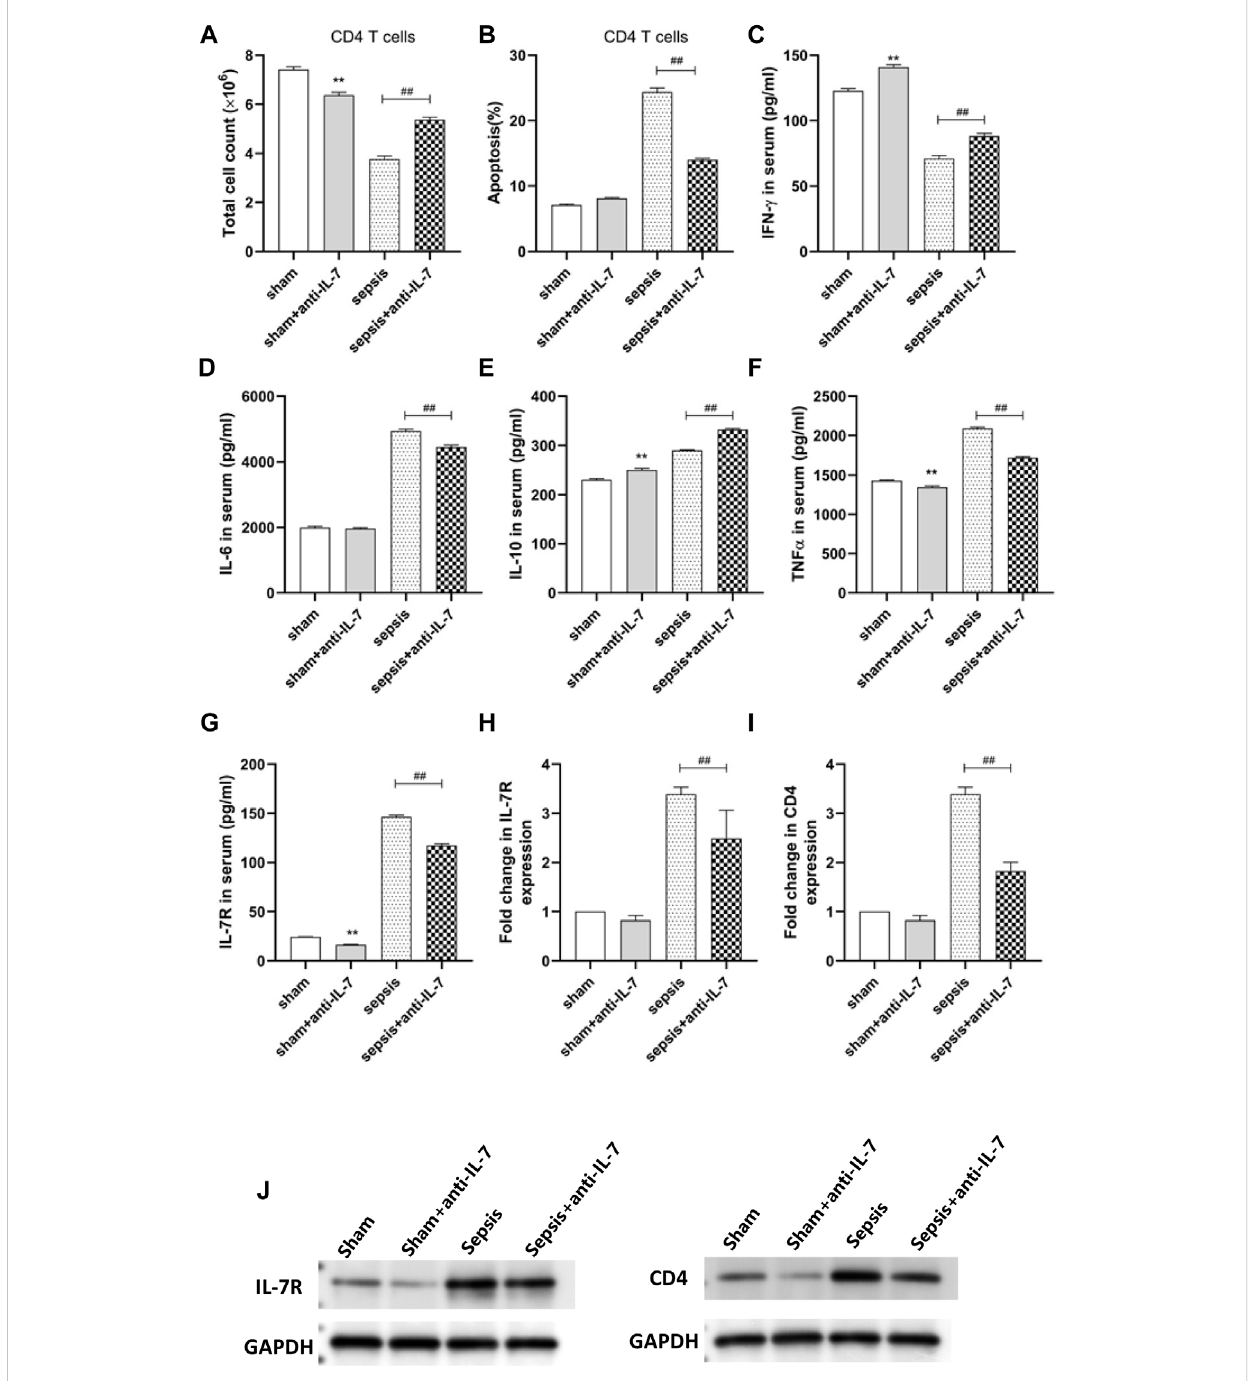
FIGURE 9 Invivo animalexperiments. (A) ThecellcountsofCD4Tcells. (B) TheapoptosisofCD4Tcells. (C) TheconcentrationofIFN- γ . (D) Theconcentration of IL-6. (E) The concentration of IL -10. (F) The concentration of TNF- α . (G) The concentration of IL-7R. (H) The expressionof IL-7R. (I) The expression of CD4. (J) Western blot